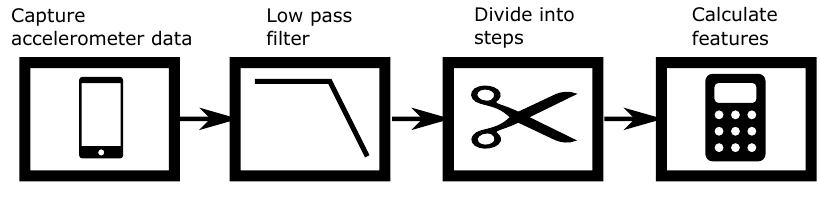
Figure 1. Process for feature extraction.